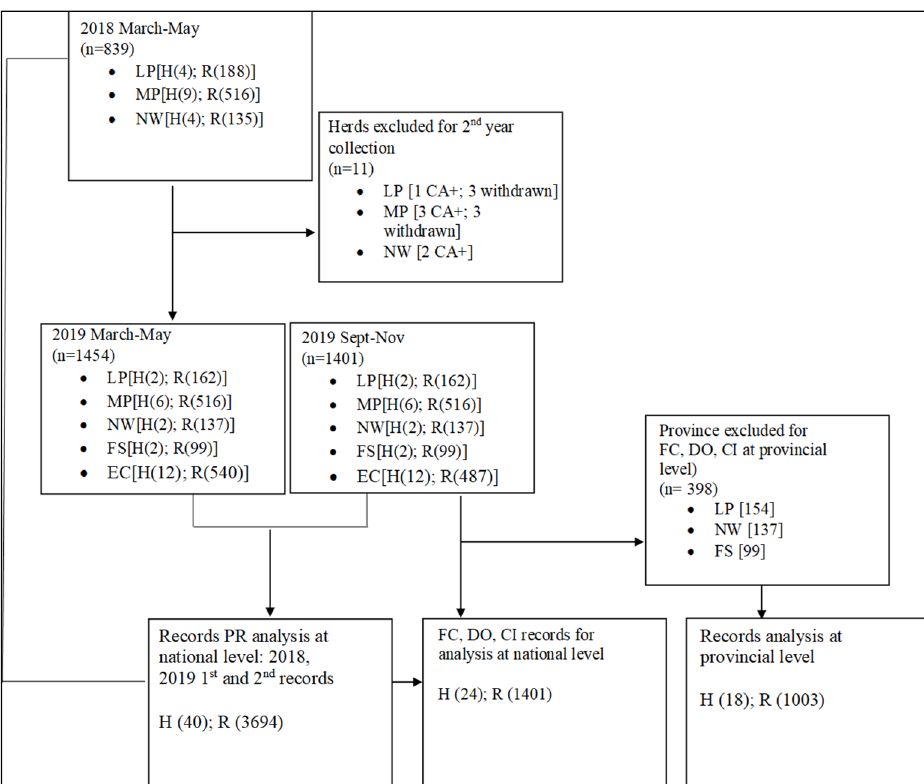
Figure 2. Demonstrate the flow of the data collected for the study in 2018 and 2019. Note: n = the number of records (R) from participating herds (H) in five provinces (EC = Eastern Cape; FS = Free State; LP = Limpopo; MP (Mpumalanga) and NW = North West) prior analysis of PR, FC, CI and DO.